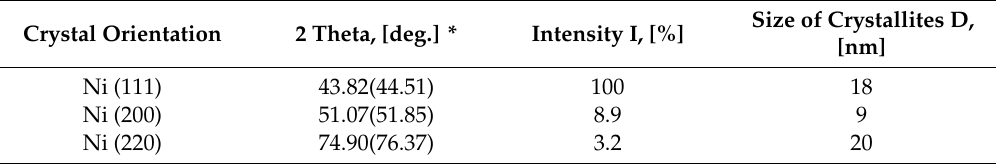
Table 2. The main properties of the XRD pattern of Ni in PAAT. Crystal